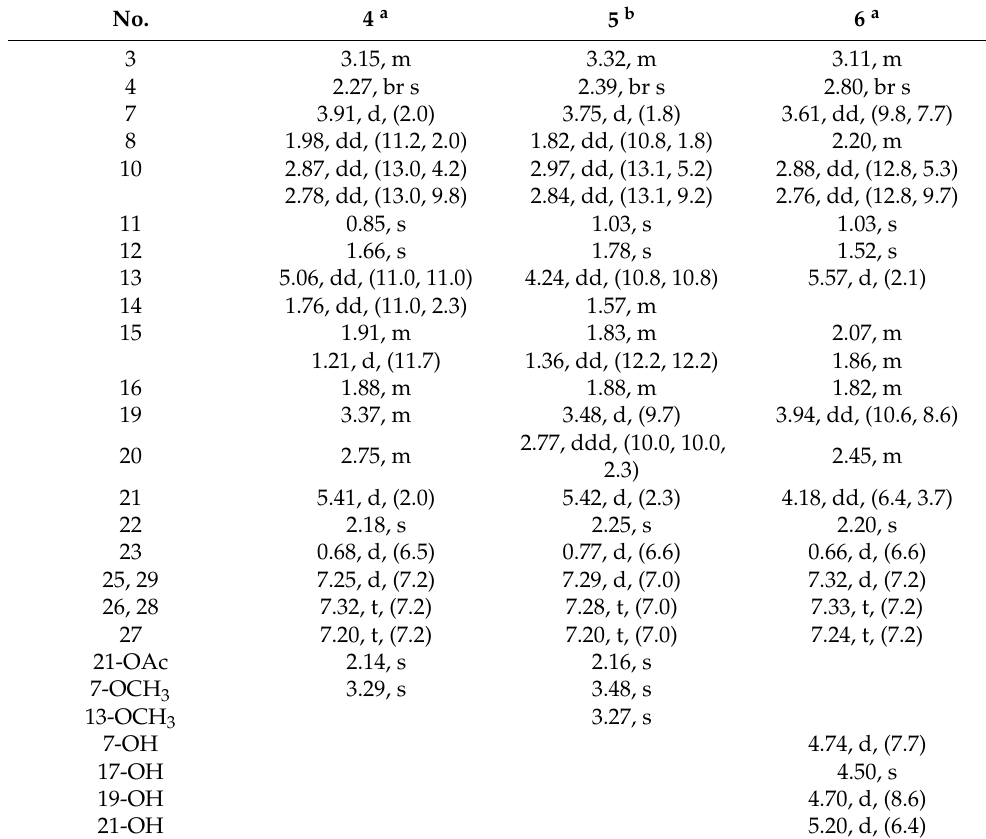
Table 3. The 1 H NMR data (600 MHz) of compounds 4 – 6 ( δ in ppm, J in Hz).